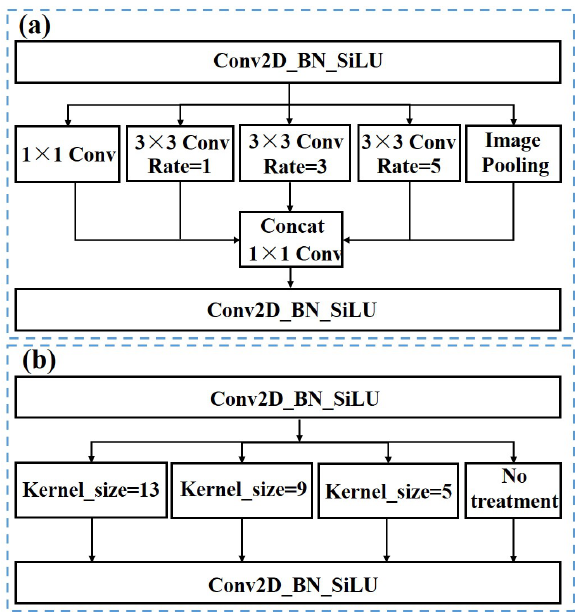
Fig. 6. The structural contrast of ASPP to SPP. (a) ASPP Bottleneck. (b) SPP